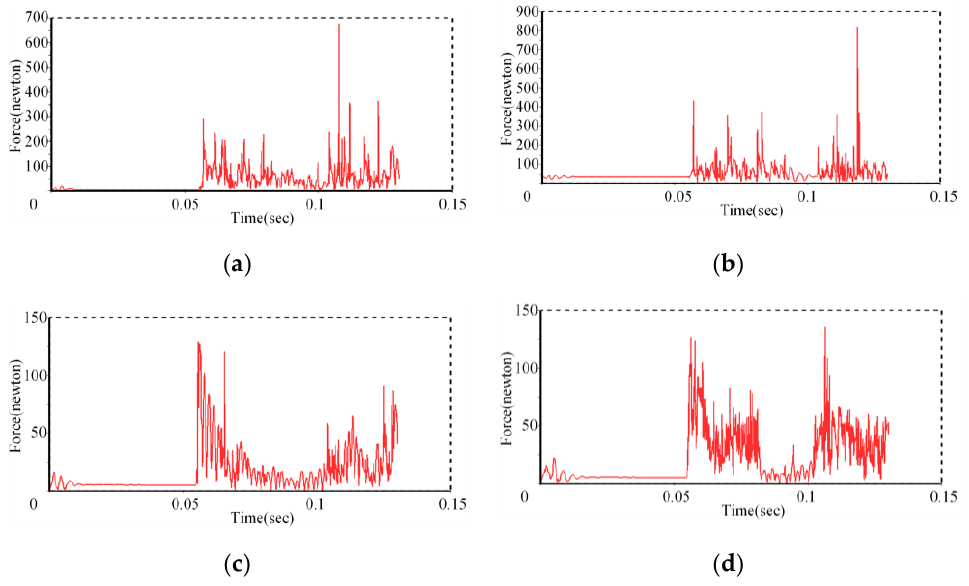
Figure 14. Contact forces between the cup bowl and the core tube.